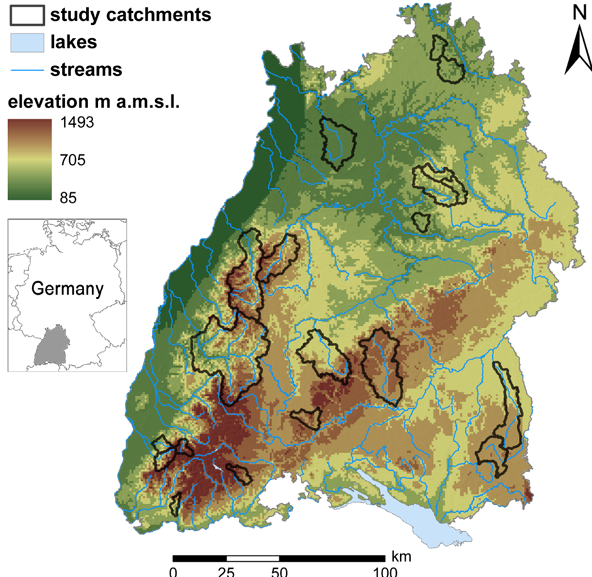
Fig. 2. Outlines and position of the 20 study catchments in Baden- W¨urttemberg, Germany. Material from d-maps.com is used for the thumbnail map of Germany (http://d-maps.com/m/europa/germany/ allemagne/allemagne15.pdf).